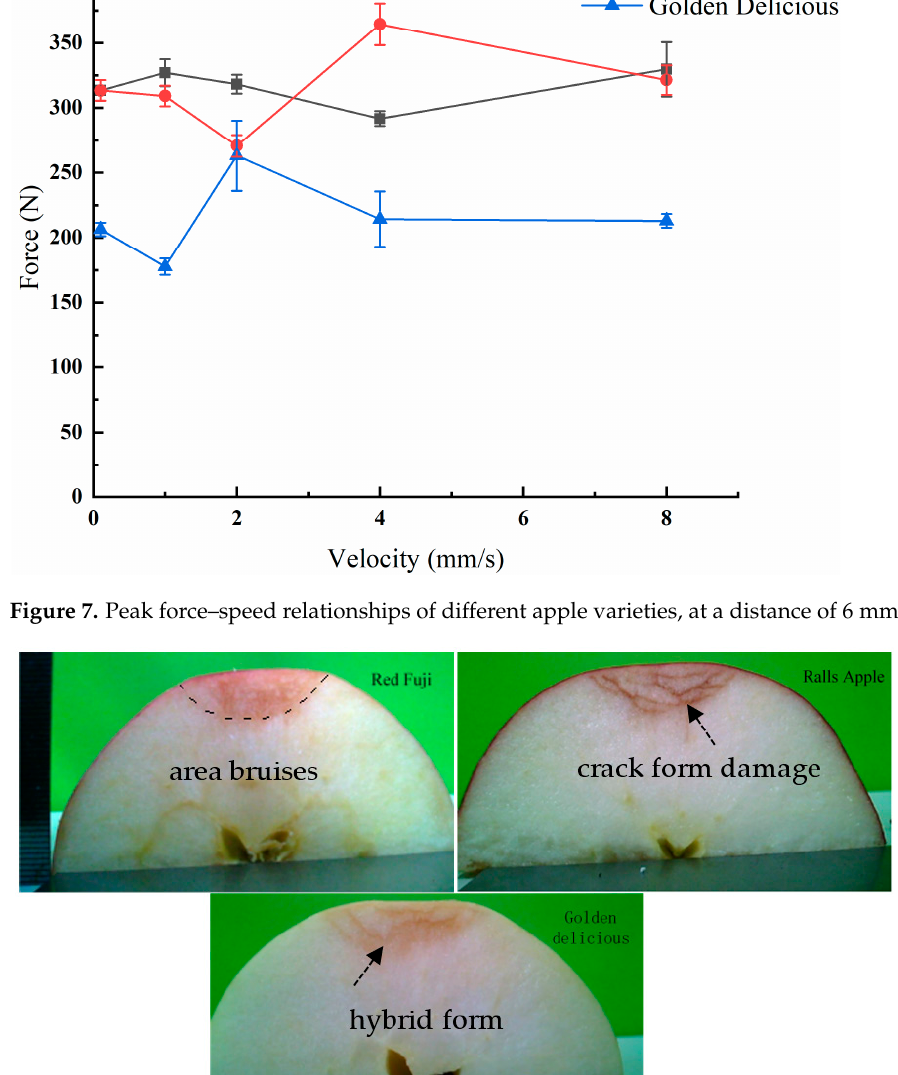
Figure 8. Damage morphology of different apple varieties under a pressing distance of 6 mm and a speed of 2 mm/s.